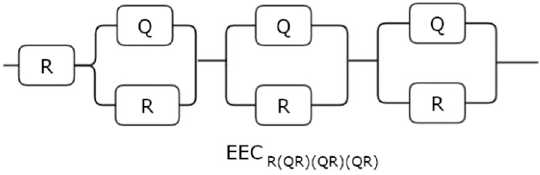
Figure 1. EEC R(QR)(RQ)(RQ) model used to fit ZARC data. The model is comprised by using three serial QR circuits. Symbol reference: R —resistor ( Ω cm 2 ) and Q —Constant Phase Element (S s n cm − 2 ). EEC R(QR)(QR)(QR) parameter values used to start fits in this study are presented in Table 3. Two types of starting parameter values were used herein. First, a good starting guess (chosen close to the optimal values), which is typical in EIS study, especially as